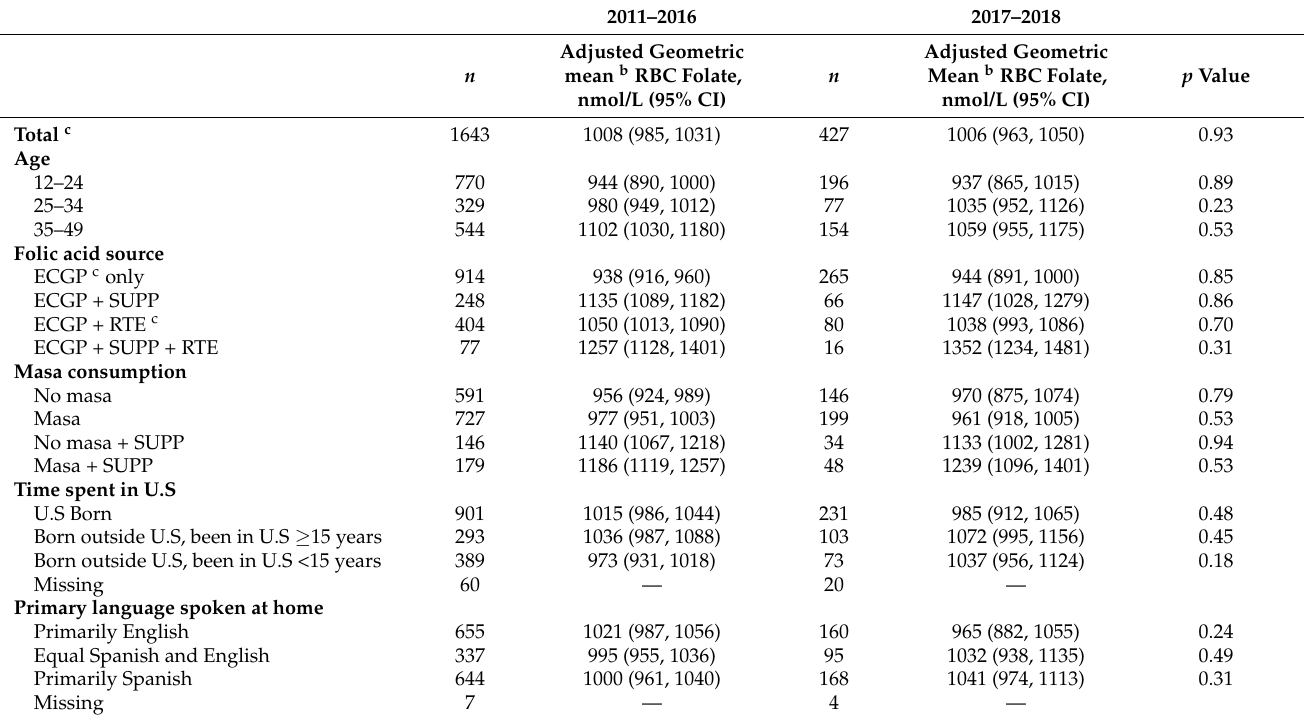
a Abbreviations: enriched cereal grain product (ECGP), National Health and Nutrition Examination Survey (NHANES), red blood cell (RBC), ready-to-eat cereals (RTE), supplement use (SUPP); b Geometric means adjusted for age, education, poverty-income ratio (PIR), ethnicity, and body mass index (BMI); c Excluded those who did not attend the mobile examination center (2011–2016: N = 76, 2017–2018: N = 23) and those who had missing RBC folate concentrations (2011–2016: N = 91, 2017–2018: N = 20); p -values determined using Student’s t